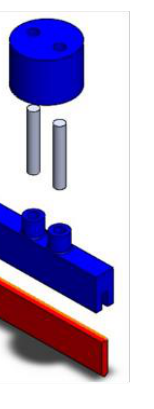
Figure A5. Squeegee holder and assembly.